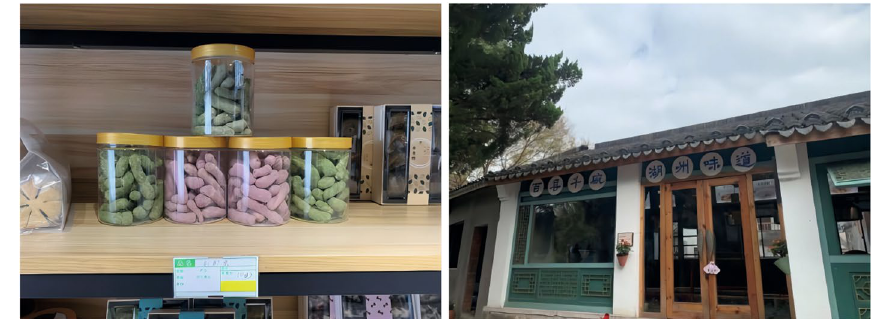
Fig. 8 Product display, sale and catering (Source: the authors)